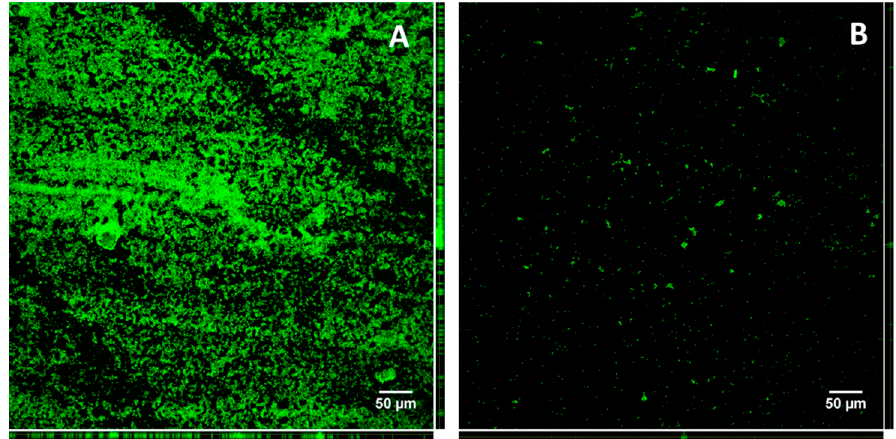
Figure 1. Total biofilm produced by KpTs101 ( A ); and KpTs113 ( B ) on glass slides. After 24 h growth the biofilms were fixed and stained with acridine orange 1% w / v . Z-stacks were acquired with a 20×/0.5 air objective at 1 µm intervals. Orthogonal views of Z-stacks are shown in the right and lower sides of each frame.